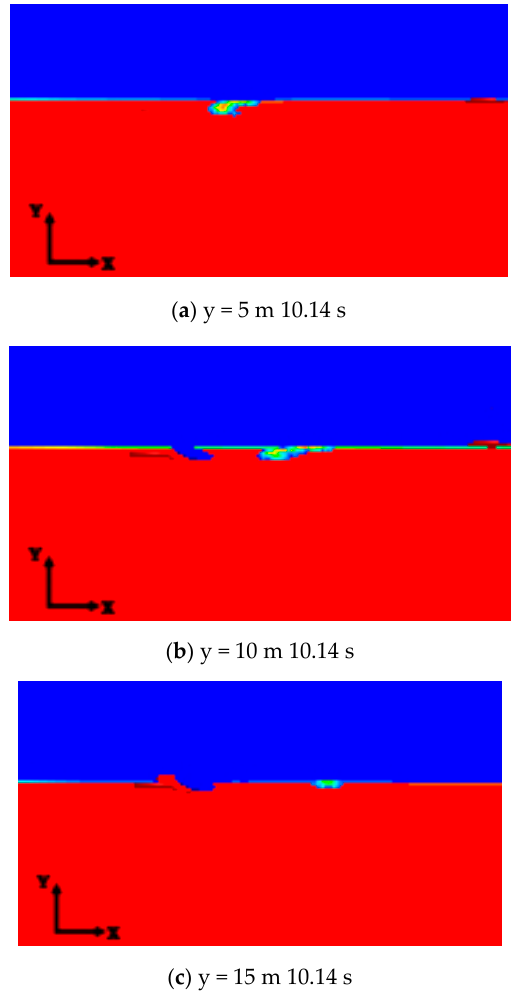
Figure 9. Three phase distribution of oil–water–air for icy waters at 10.14 s.